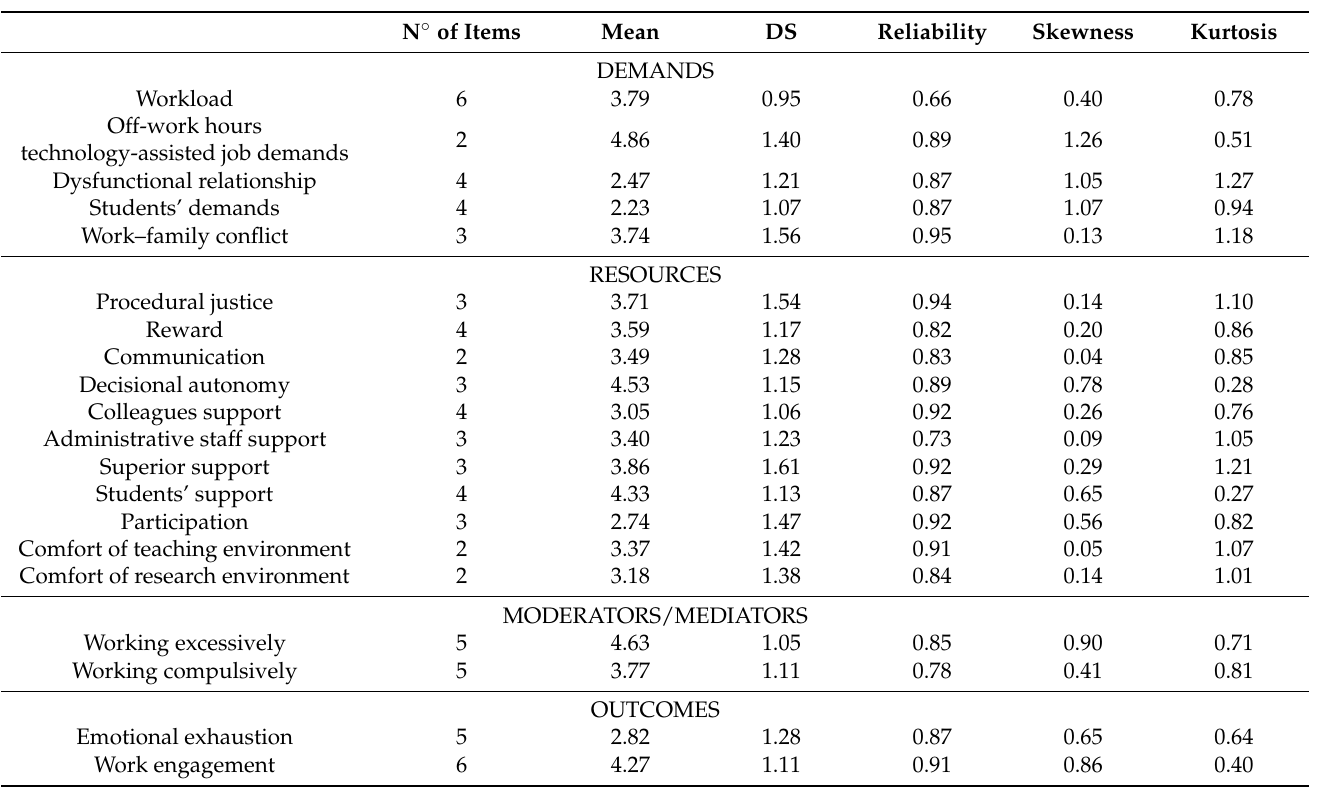
Table 1. Principal descriptive analysis of the calibration sample (N = 1084).